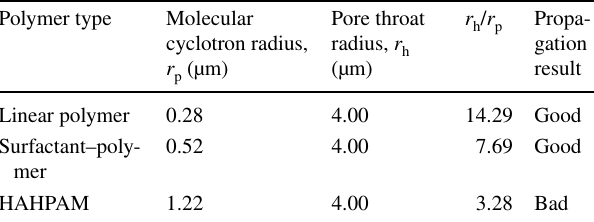
Table 3 Summary of polymer molecular sizes and propagation behavior in the sandpack Polymer type Molecular cyclotron